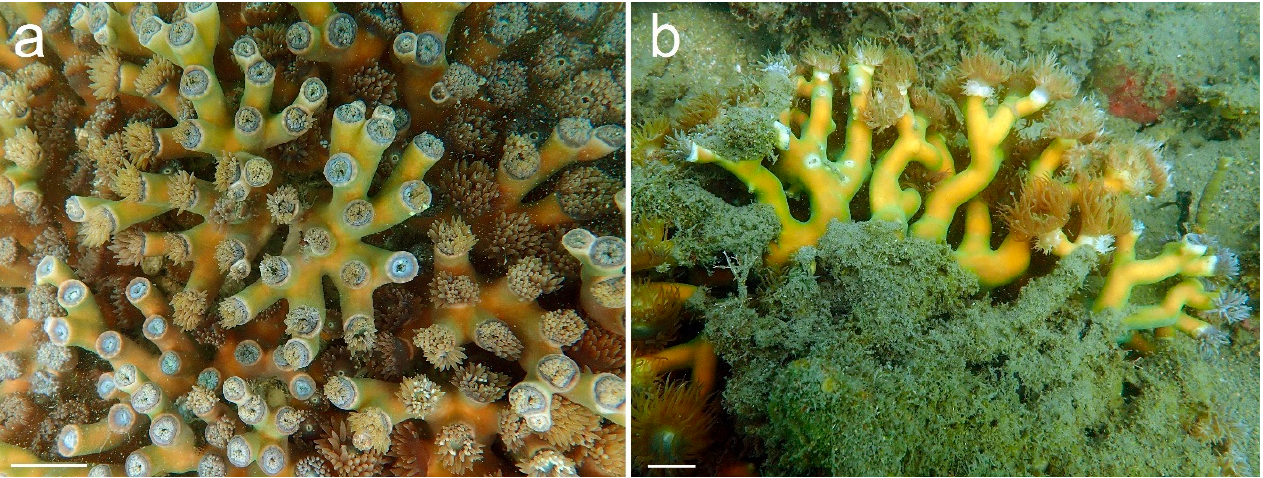
Figure 3. Duncanopsammia axifuga colonies with tentacles contracted showing branching pattern. ( a ) Large colony viewed from above. ( b ) Unattached coral from aside with partial mortality at the coral basis. Scale bars: 2.5 cm.